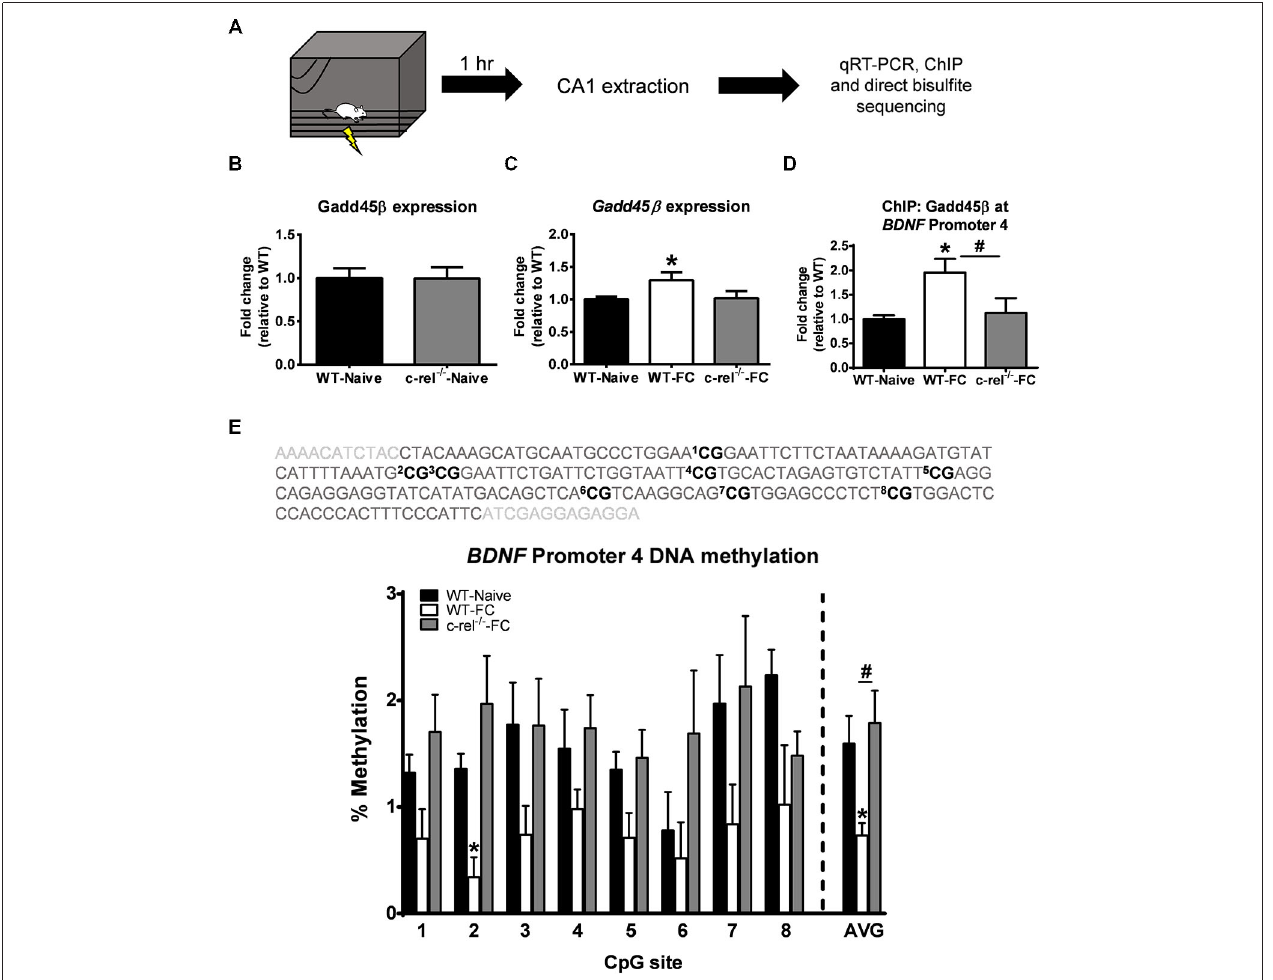
FIGURE 4 | Knockout of c-rel prevents fear conditioning-induced changes in Gadd45 β expression and BDNF DNA methylation in the hippocampus. (A) Wild-type (WT) or c-rel knockout ( c-rel − / − ) mice were fear conditioned and area CA1 collected 1 h later. (B) Basal expression of Gadd45 β was not altered in c-rel − / − mice ( n = 4–5 per group). (C) Gadd45 β expression was increased in WT, but not c-rel − / − , mice following fear conditioning ( n = 8 per group). (D) Chromatin immunoprecipitation revealed an increase in Gadd45 β binding at BDNF Promoter 4 following fear conditioning, which was lost in c-rel − / − mice ( n = 4 per group). (E) Bisulfite sequencing analysis of CpG sites in the mouse BDNF Promoter 4 region revealed a fear conditioning-induced decrease in BDNF Promoter 4 DNA methylation in area CA1 that was prevented in c-rel − / − mice ( n = 3–4 per group). ∗ p < 0.05 from WT. # p < 0.05 from WT-FC.